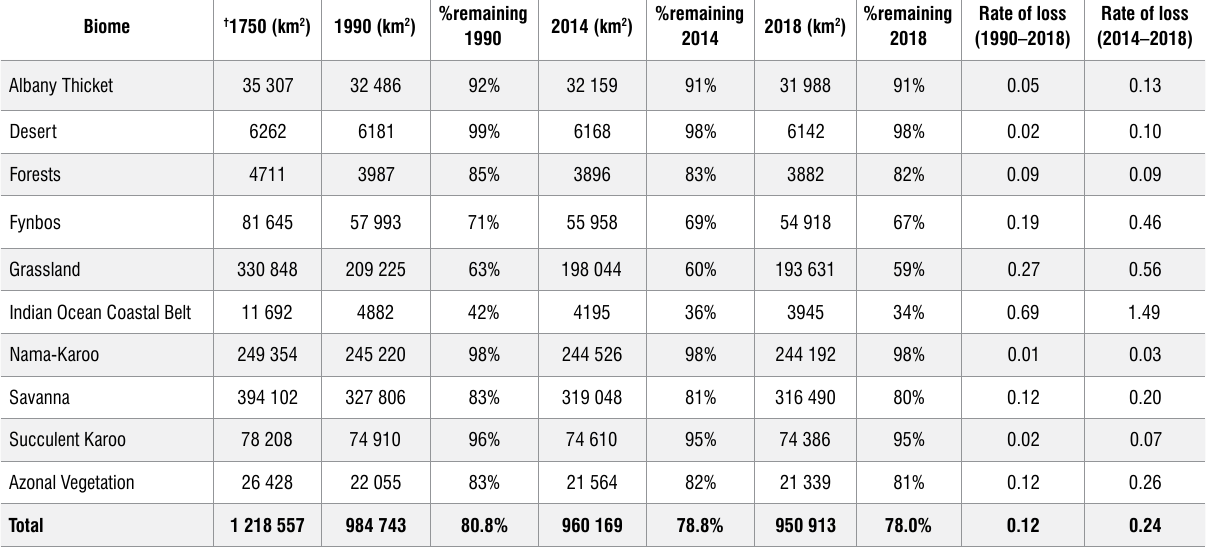
Remaining natural extent (RnE) per biome at each time point in the land-cover change time series. The table includes the rate of habitat loss (RoL) between 1990 and 2018, and between 2014 and 2018.